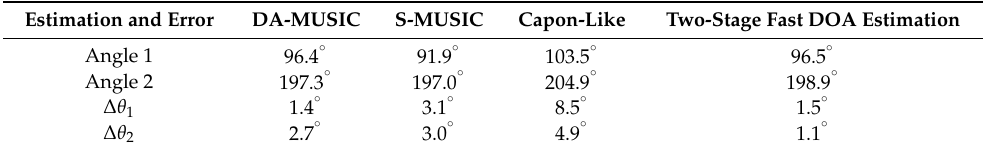
Table 8. Anechoic chamber experiments values and